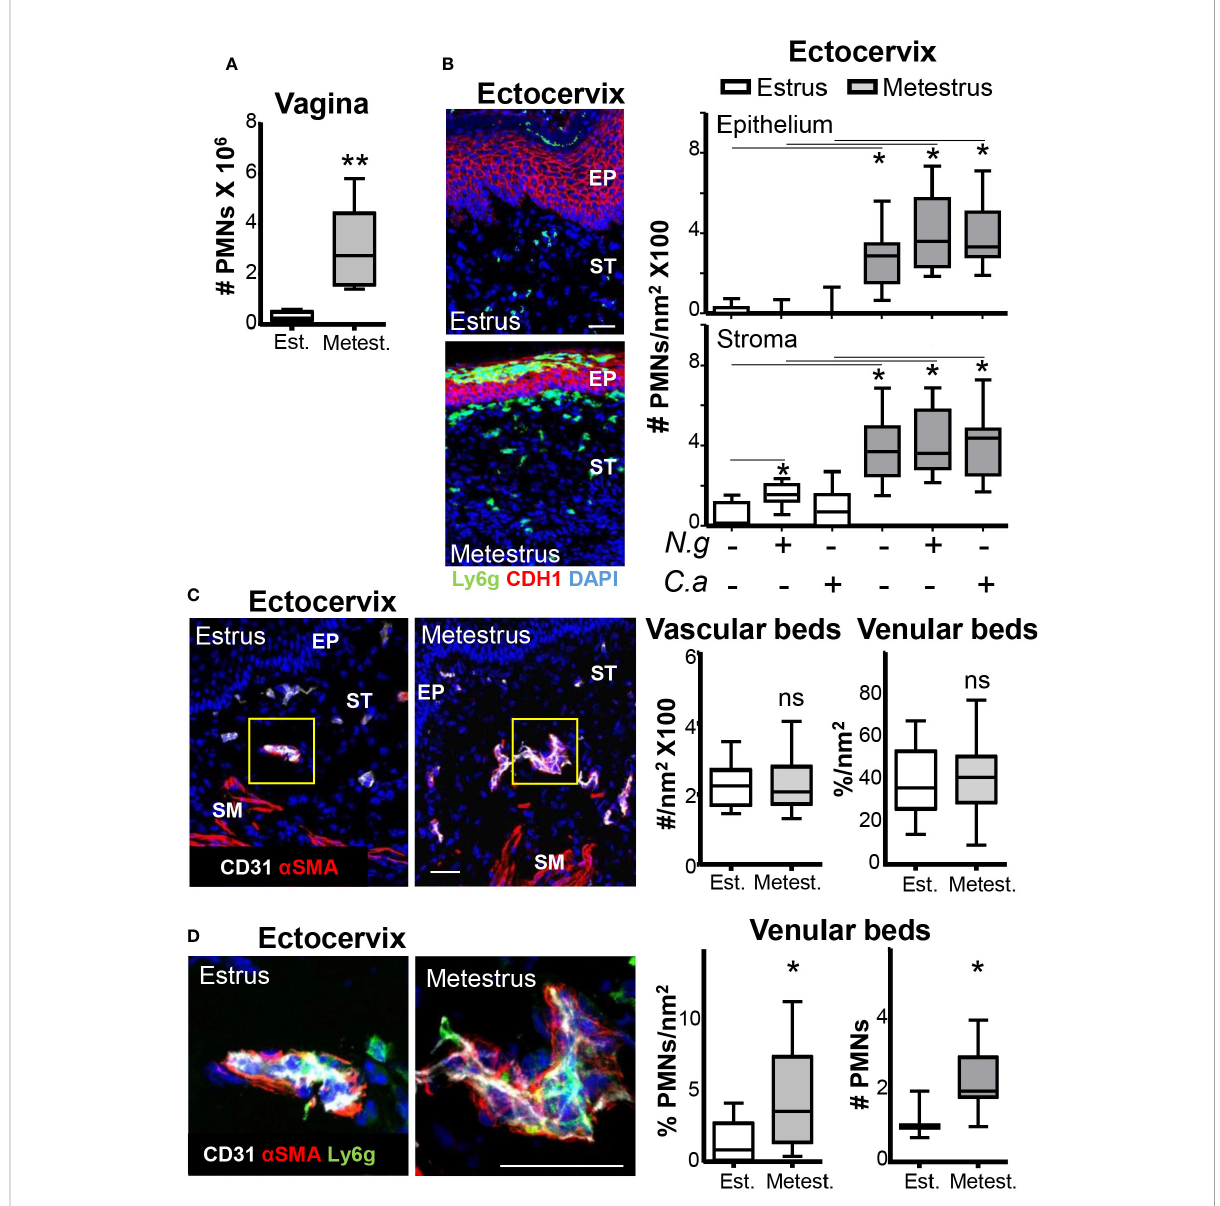
FIGURE 3 Neutrophils in the ectocervix during the ovarian cycle. Adult female mice were selected by vaginal smear. (A) Number of neutrophils in the vaginal tissue by fl ow cytometry. (B) Photomicrograph of the ectocervix of estrus and metestrus mice. Ly6g+ cells (neutrophils) in the cervical epithelium and stroma of estrus and metestrus mice mock or Neisseria gonorrhoeae or Candida albicans challenged. Data were calculated in at least 3 different sections of each sample. (C) Photomicrograph of the vascular and venular beds stained in the ectocervix of estrus and metestrus mice and quanti fi cation. (D) Quanti fi cation of vascular and venular beds neutrophil intraluminal adhesion. Data expressed as box and whiskers 10-90 percentile (n= 5 – 6 mice per group). *p < 0.05, **p < 0.01 and ns p > 0.05 Mann-Whitney. Scale bar, 50 µm. Est, Estrus; Metest, Metestrus; a SMA, a smooth muscle actin; Ep, epithelium; St, Stroma; Ng, Neisseria gonorrhoeae and Ca, Candida albicans